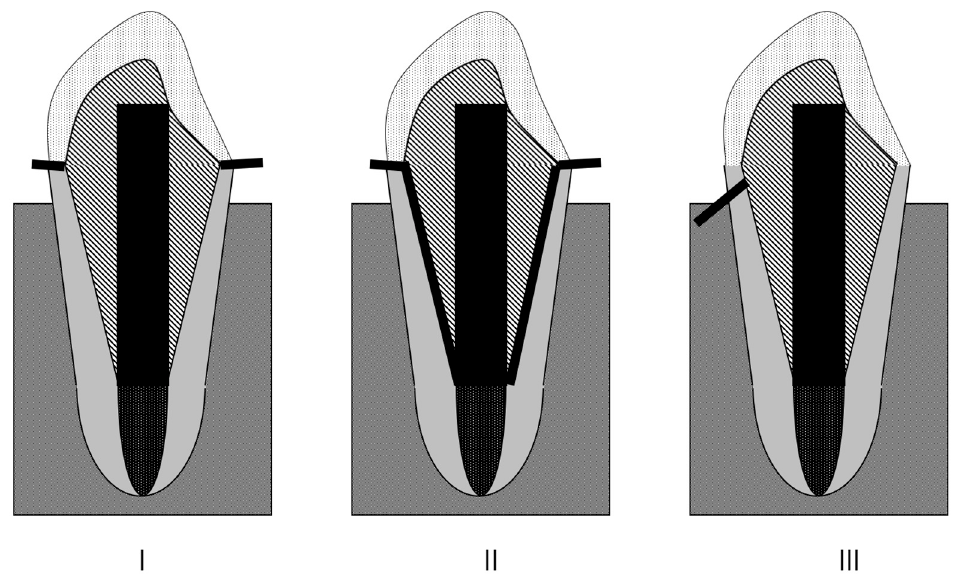
Figure 3. The types of fracture mode. ( I ) The type that fracture ends above the CEJ. ( II ) Detachment of core construction. ( III ) The type that extends below the CEJ.